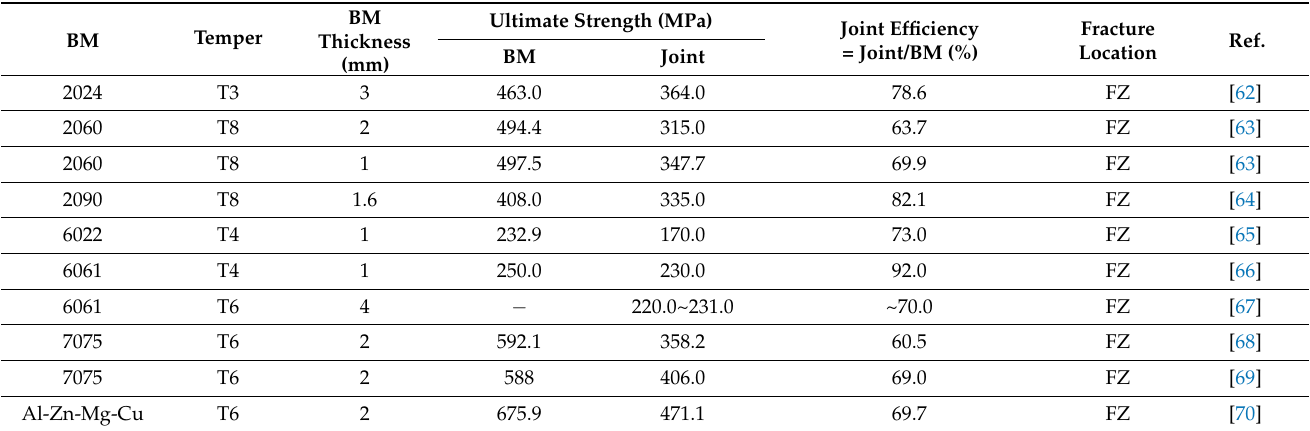
Table 5. Summary of the tensile properties of autogenous LBW age-hardening aluminum alloy butt joint. BM